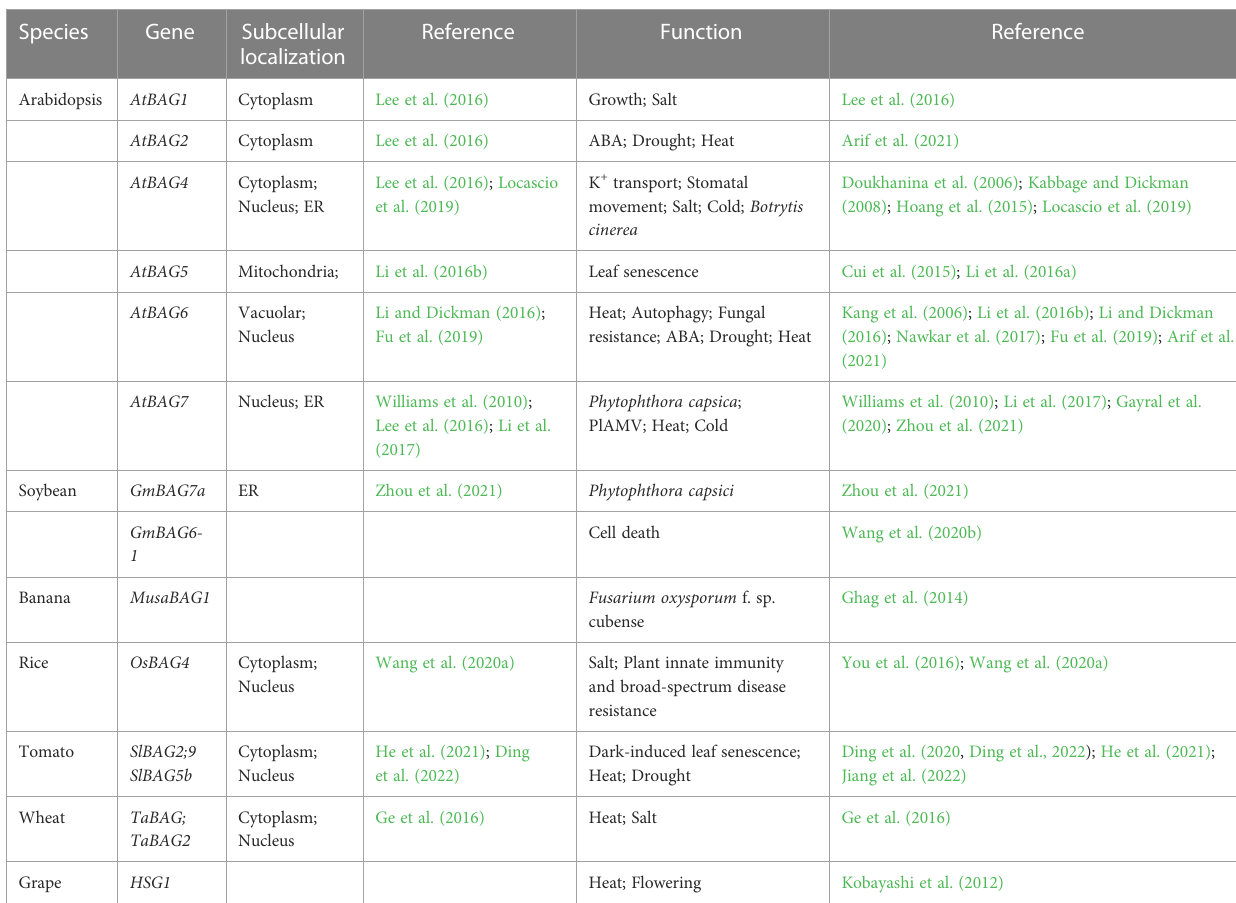
TABLE 1 The functional studies of plant BAGs in plant development and stress tolerance.